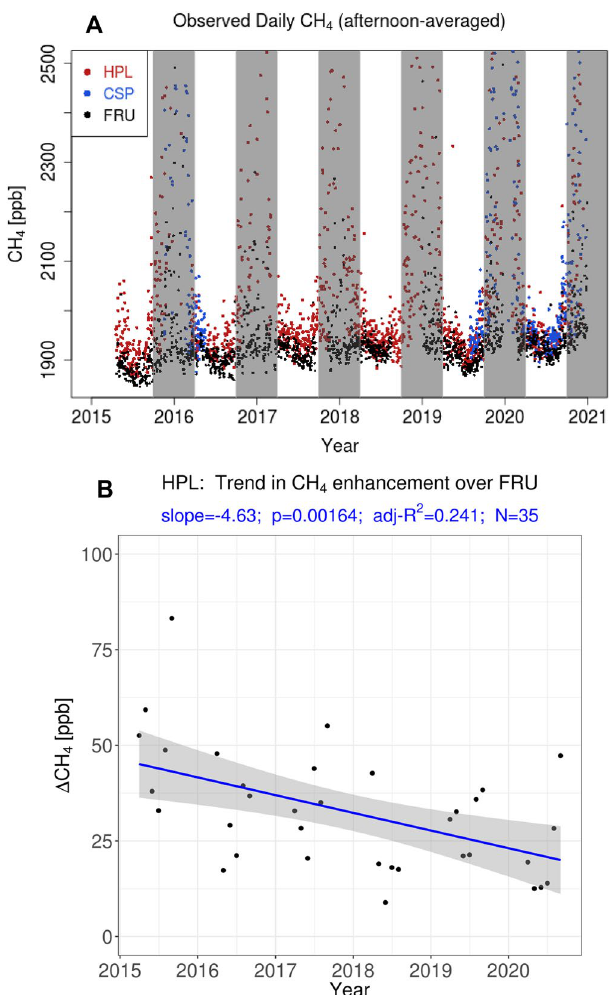
Figure 2. Time series of observed CH 4 time series in the Uinta Basin between 2015 and 2020. ( A ) Observed daily CH 4 averaged over afternoon hours (13:00 to 16:00 MST) at the HPL, CSP, and FRU sites. Gray regions cover the cold season spanning the months of Oct to Mar, when CH 4 values can rise dramatically at especially HPL and CSP to > 3000 ppb (off-scale), especially during stable, cold air pool conditions that are difficult for atmospheric models to simulate with fidelity. To filter out the cold air pool conditions, a subset of months from Apr to Sep are chosen for analysis with the atmospheric model in order to calculate CH 4 emissions. ( B ) Observed afternoon enhancements in CH 4 at HPL over the baseline observed at FRU, averaged monthly from 2015 to 2020. The decreasing trend line derives from an ordinary least square regression; the resulting slope, p -value, adjusted-R 2 , and number of points ( N ) are shown in blue. Gray shading indicates 95% confidence interval of the fitted trend